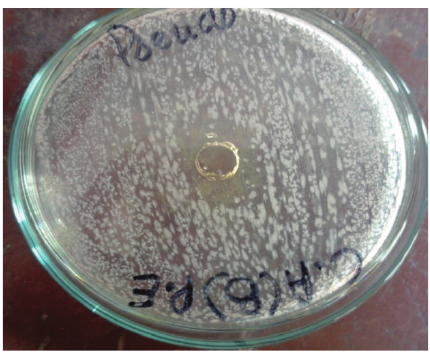
Figure 25: Zone of inhibition of petroleum ether extract of bark of C. ambrosioides L. against P. aeruginosa